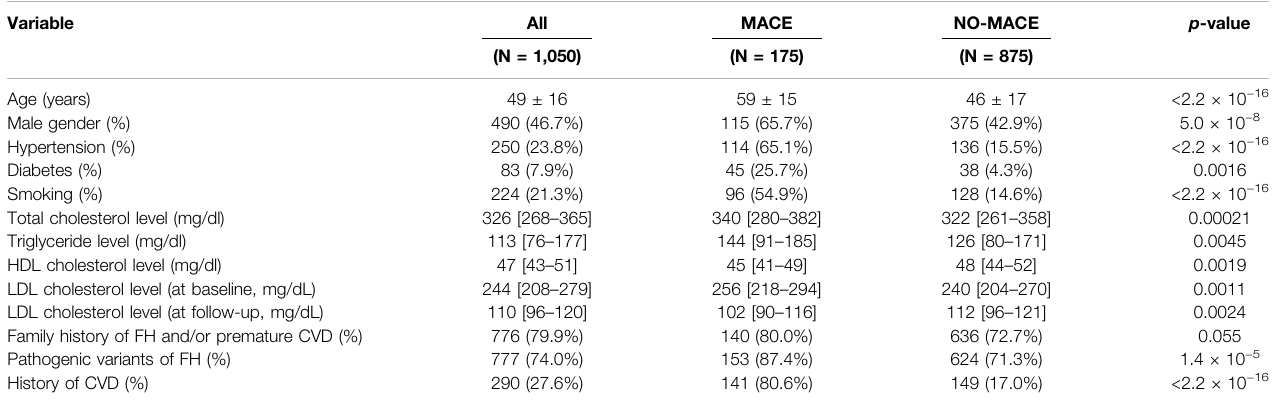
TABLE 1 | Baseline characteristics.